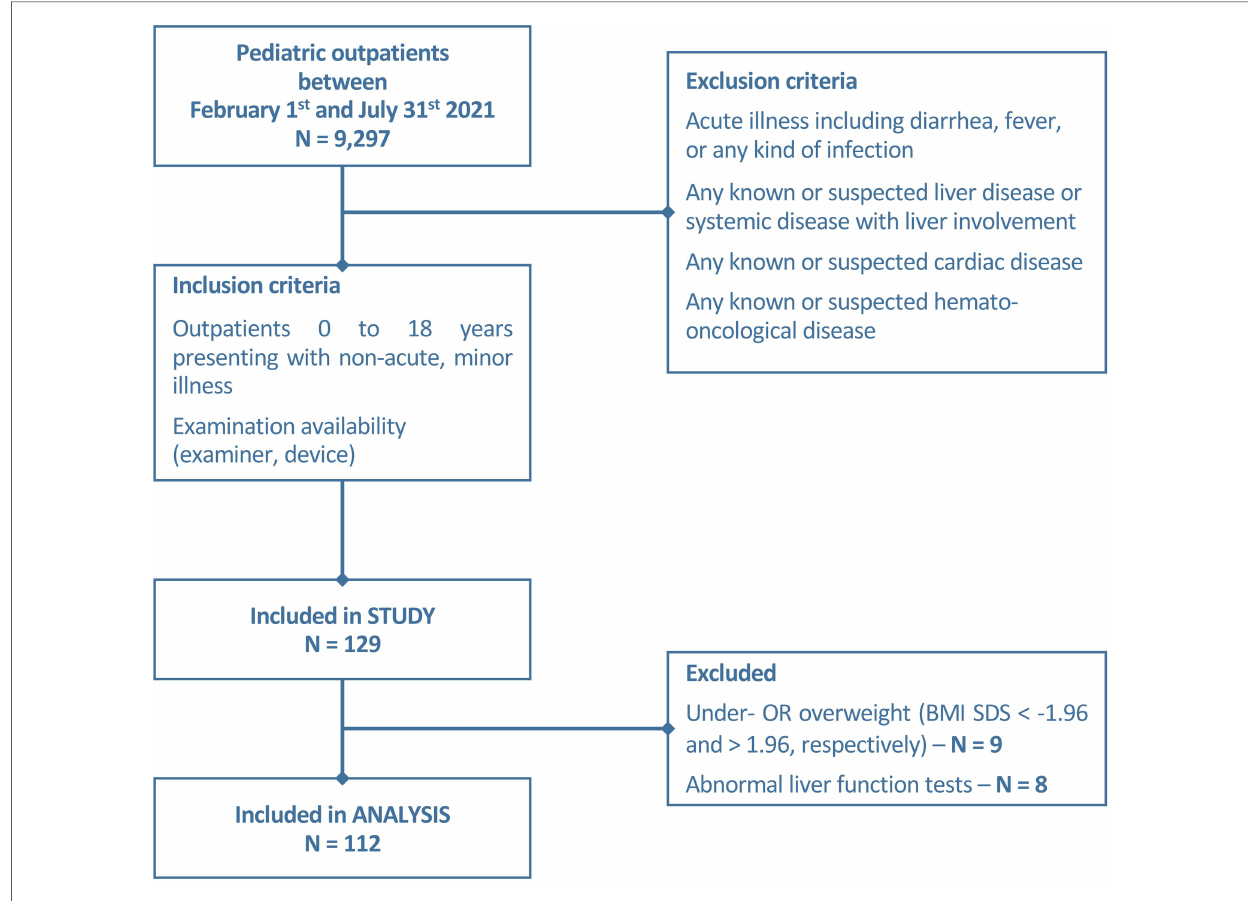
FIGURE 1 Flowchart describing the recruitment of study